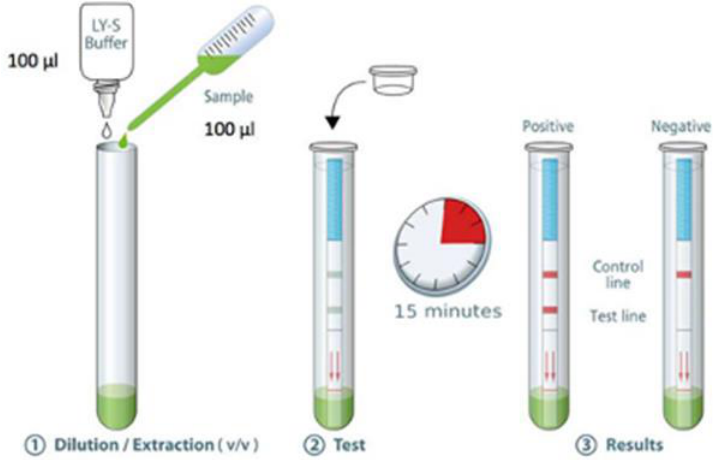
Figure 6. Working principle of SARS-COV-2 Respi-Strip© . Reproduced from Reference [201], under the Creative Commons Attribution License.